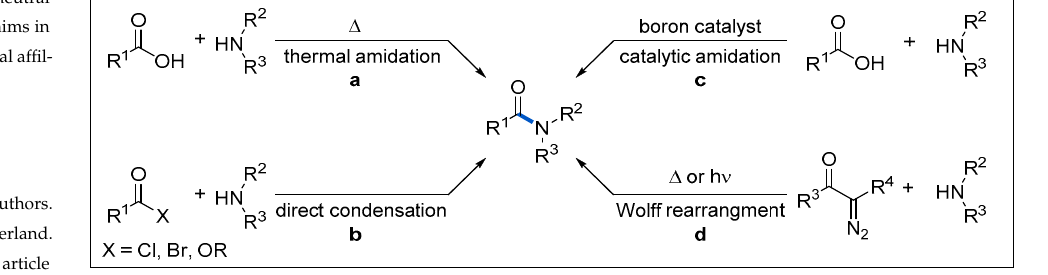
Figure 1. Selected traditional methods for amide synthesis.